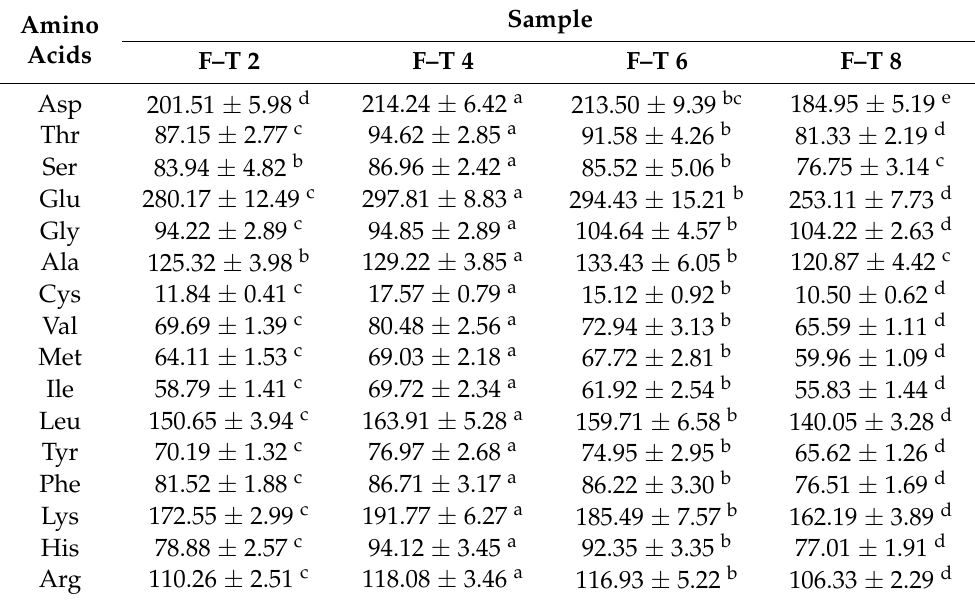
Figure 1. The K-value of the samples in varying freeze–thaw (F–T) cycles. Table 2. Changes in the amino acid composition (mg/g) of T. murphyi in varying freeze–thaw (F–T) cycles .